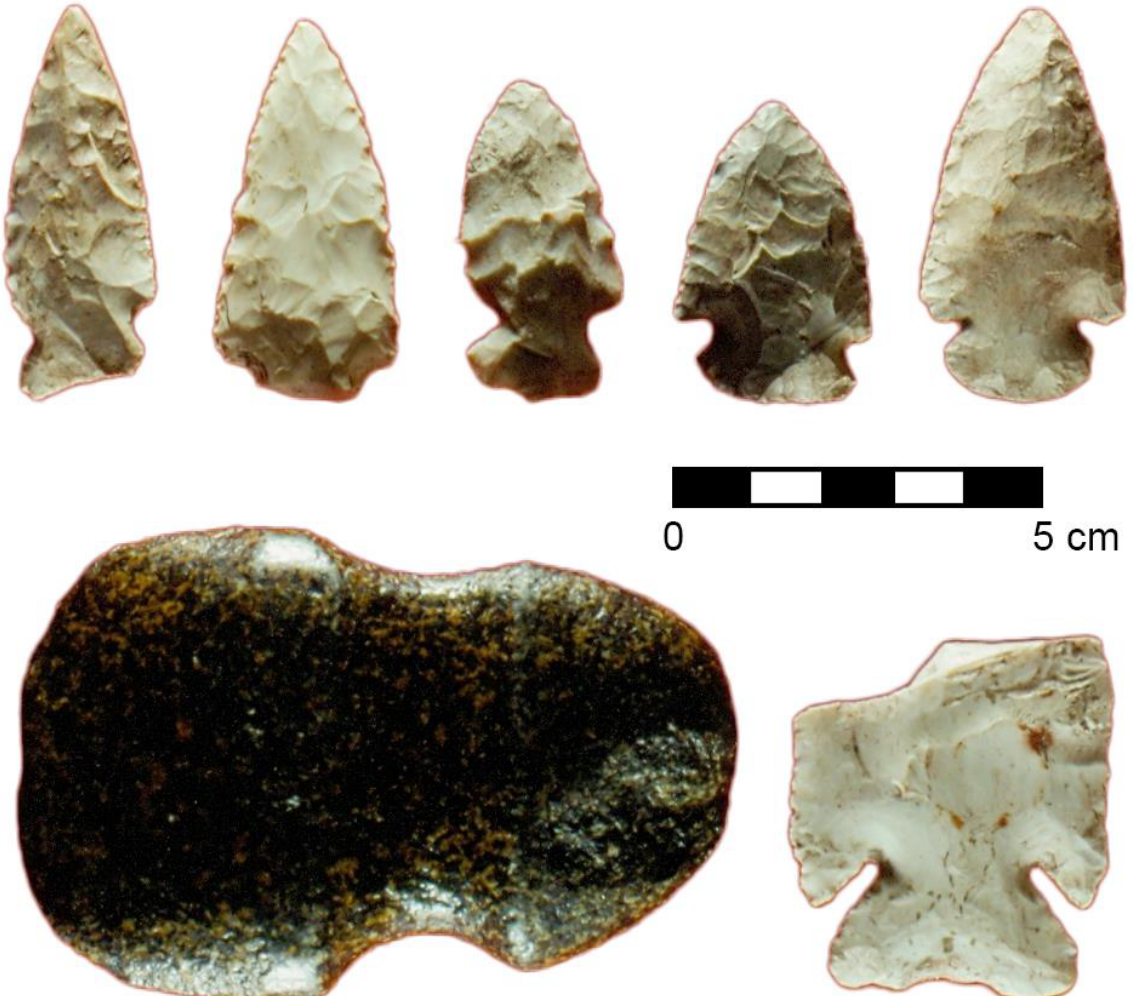
Figure 31. Archaic period spear points, knives and small axe from a private collection gathered by family members on the Star-Being farm and property. The axe is made of gabbro, the points from local cherts. The two blades at right are early Archaic dating approximately 6000 BCE. All others including the axe date between 3000-1000